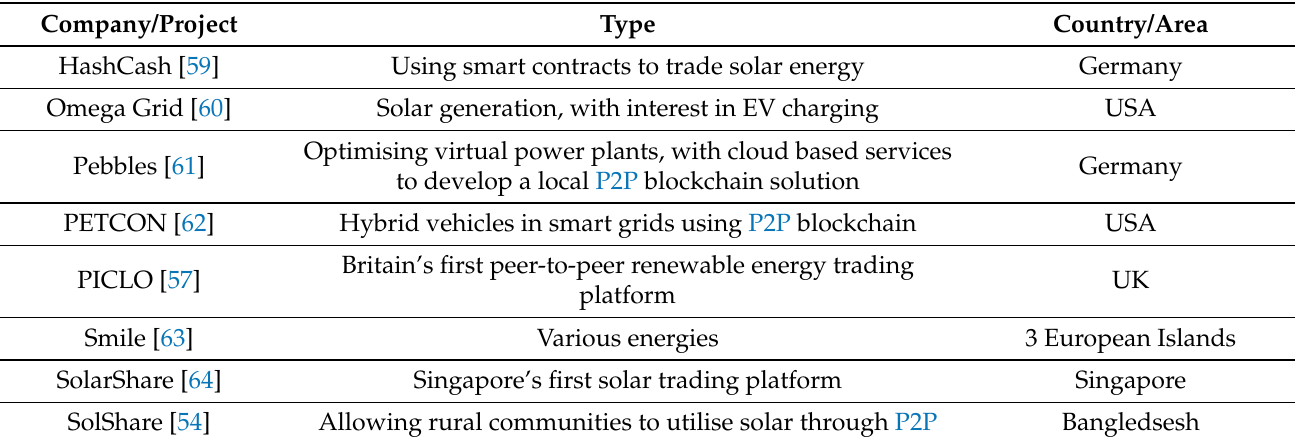
Table 4. P2P projects and